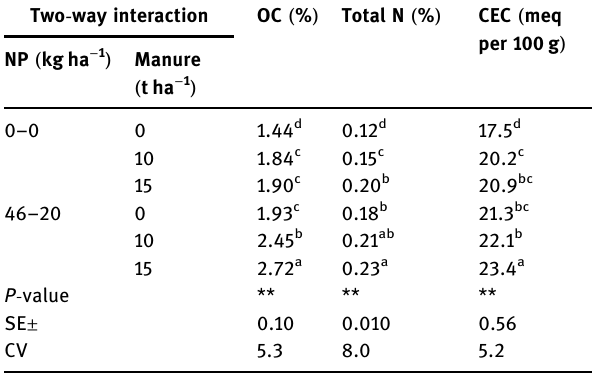
Table 2: Interaction e ff ects of cattle manure and NP fertilizers on OC, total N, and CEC after tef harvest in main cropping season in northwest Ethiopian highlands Two - way